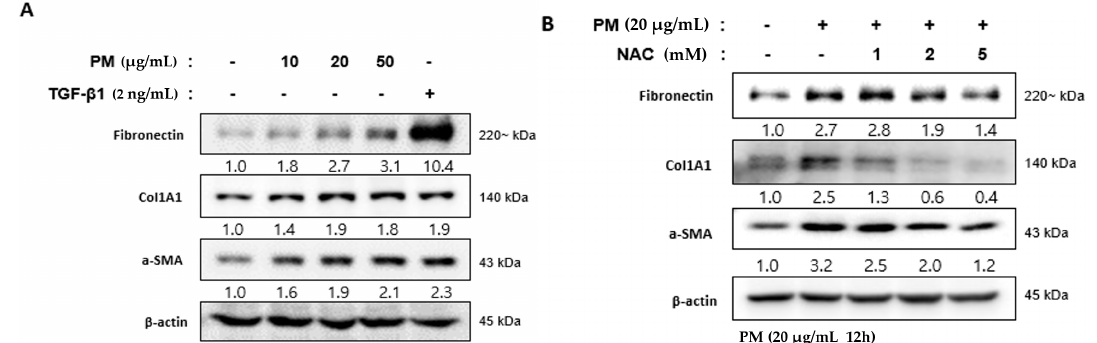
Figure 5. PM-induced di ff erentiation of hVFF into myofibroblasts. ( A ) Fibrosis-related molecules were measured by Western blot. Fibronectin, ColA1, and α -SMA increased after the PM treatment, similar to after the TGF- β 1 treatment (2 ng / mL). Cells were treated with various concentrations of PM (0–50 µ g / mL) for 12 h. ( B ) The increased expression of fibronectin, ColA1, and α -SMA was reduced by NAC (0–5 mM). Cells were treated with PM (20 µ g / mL) for 12